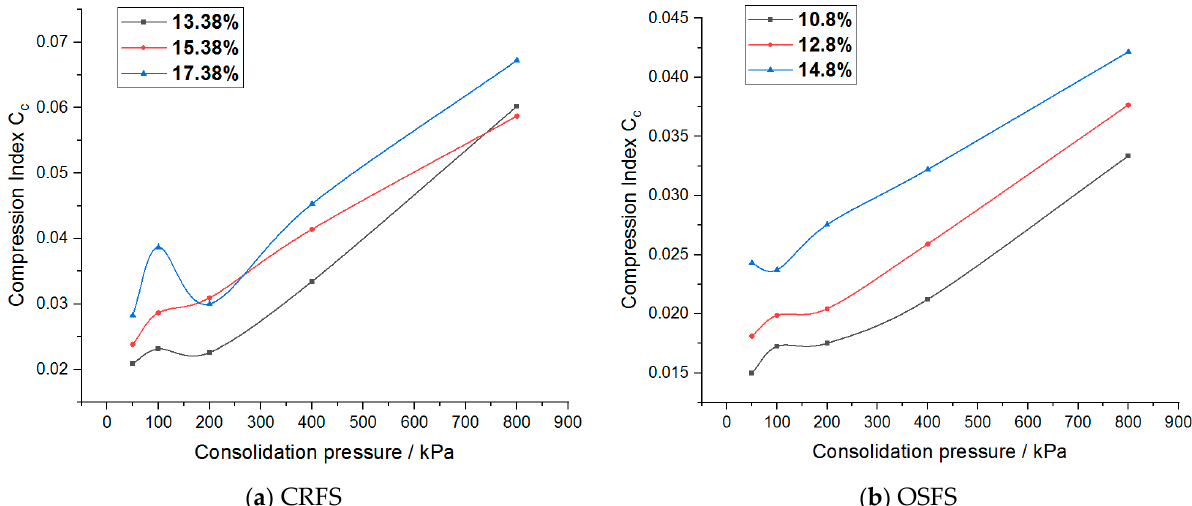
Figure 16. Compression index of modified soil with different water contents.